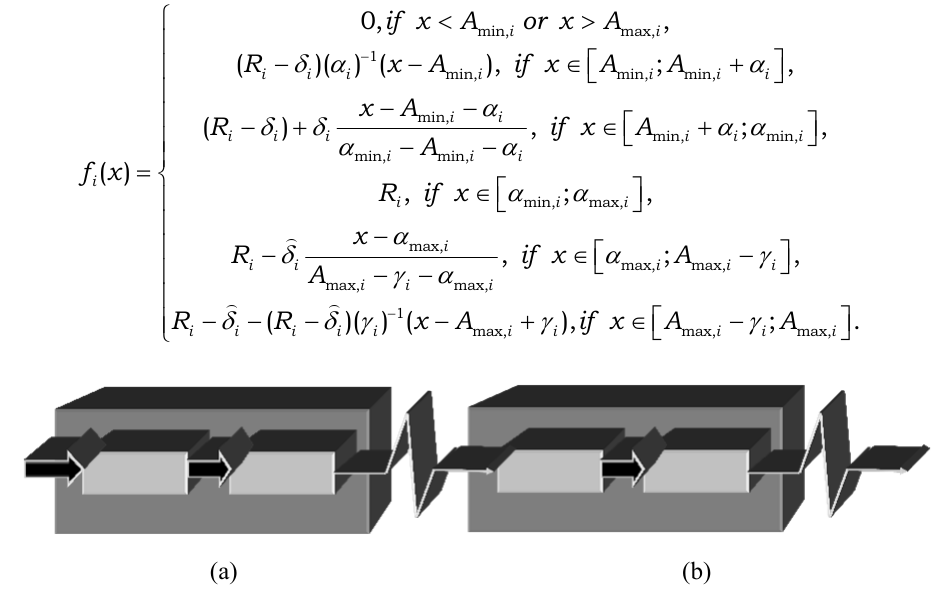
Fig. 4. Schematic structure of a technological flow with a semi-rigid connection. M Table 4. p